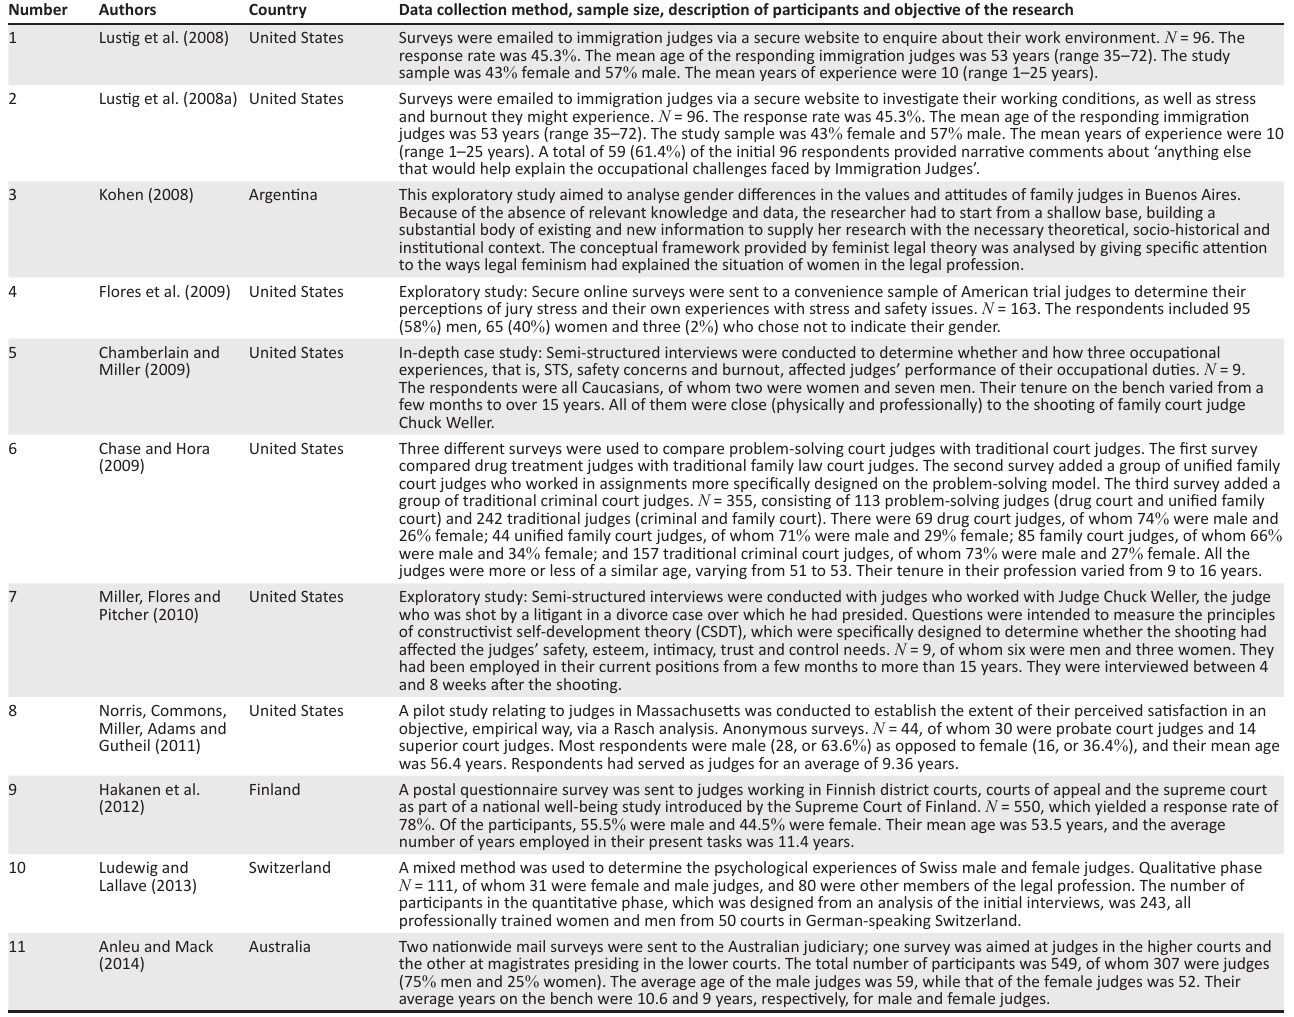
TABLE 1: Summary of studies